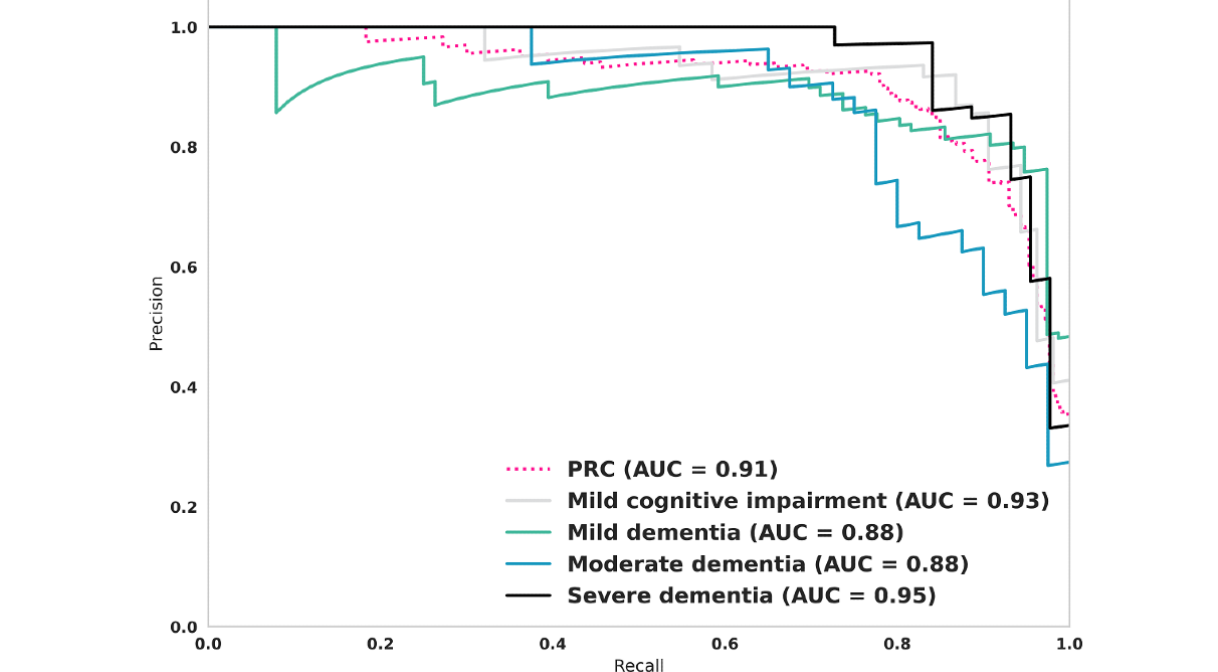
Figure 4. Precision-recall curves for each dementia stage as predicted by the model. AUC: area under the curve; PRC: precision-recall curve.